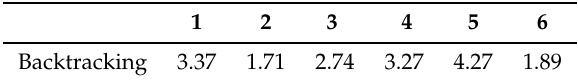
Table 2. The reduction of the trace sum of the landmarks registered in the SLAM state at the time when revisiting was planned and started.